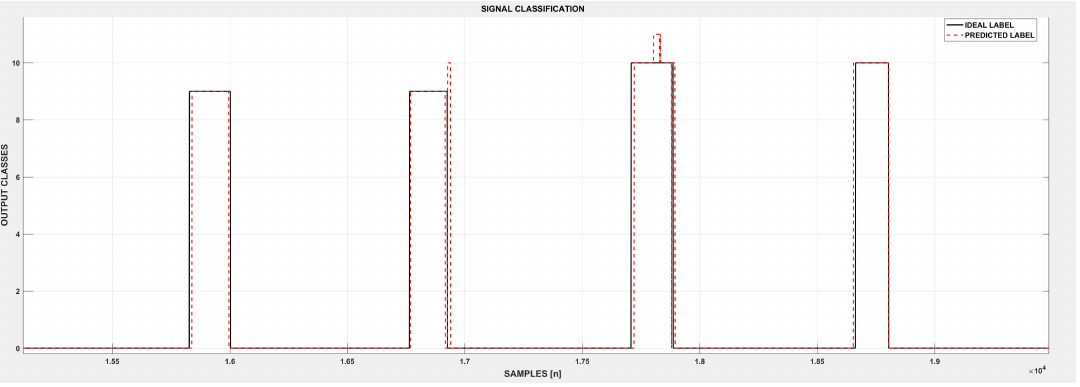
Figure 9. A label comparison plot: Through the analysis of the ideal and predicted label, it is possible to estimate the classification errors and propose specific solutions. In the figure, two repetitions of Movements 9 and 10 performed by Subject 1 in Assay A were used to illustrate the capability of the